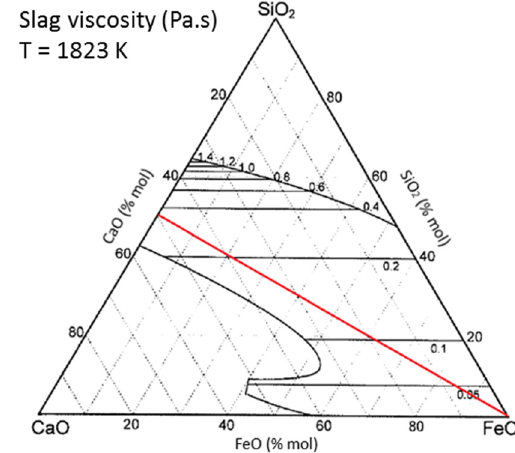
Figure 5: Viscosities of CaO-SiO2-FeO slag at 1823 K – calculated by Urbain’s model. With an iso basicity line B2=1.